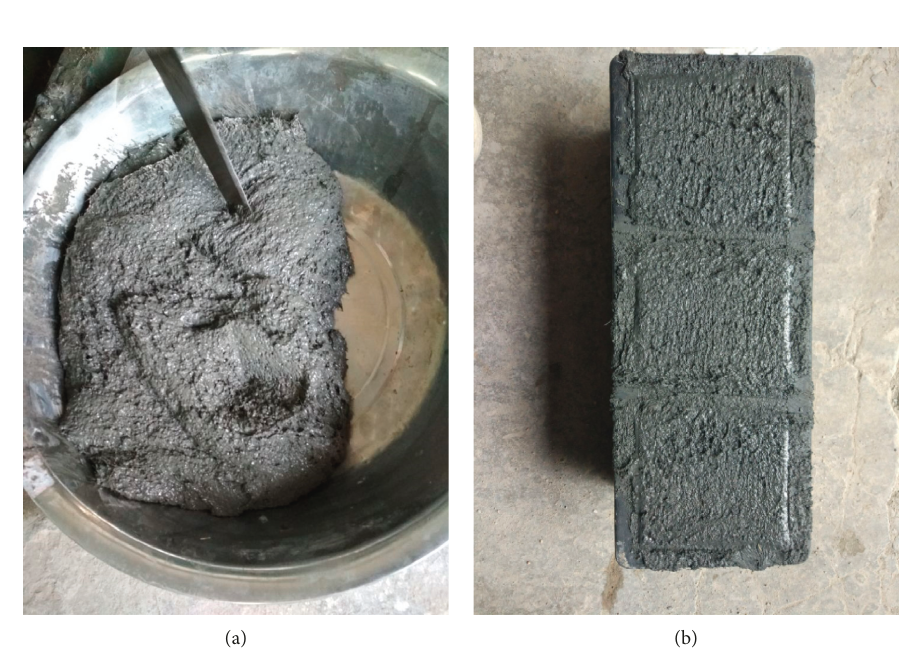
Figure 2: Photos of specimen preparation.